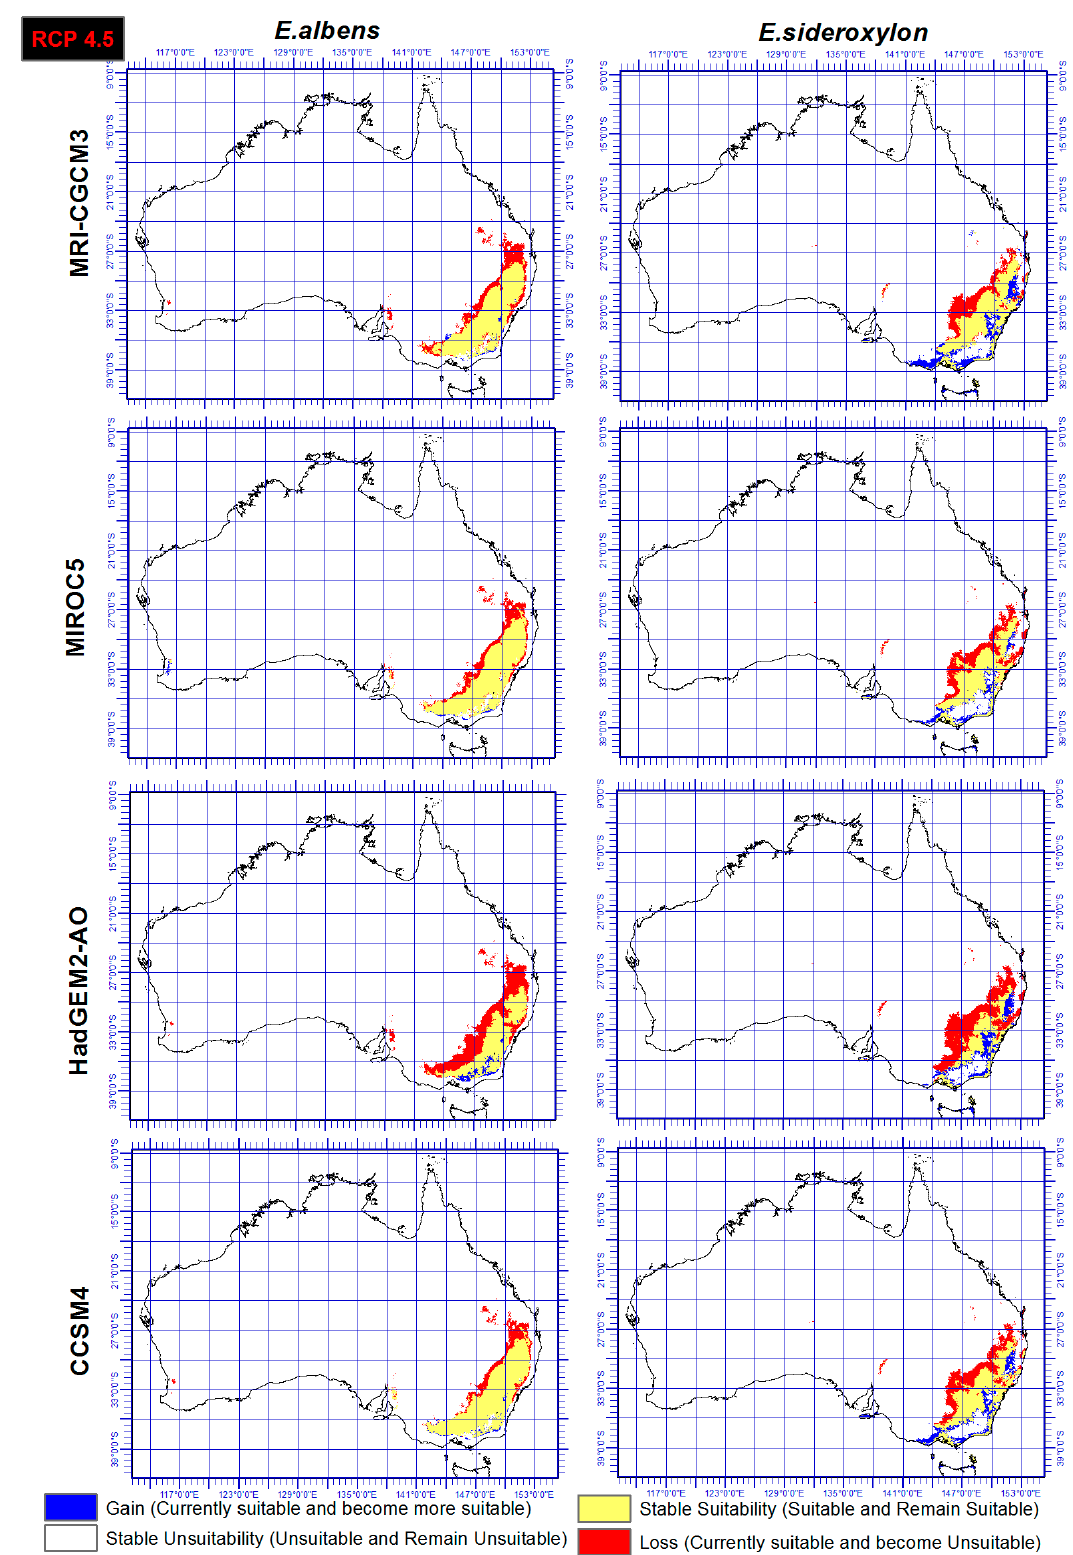
Figure 4. Ensemble output of four SDMs, under RCP 4.5 and four GCMs indicating range gain, loss or as is of Eucalyptus sideroxylon and E. albens by 2050.